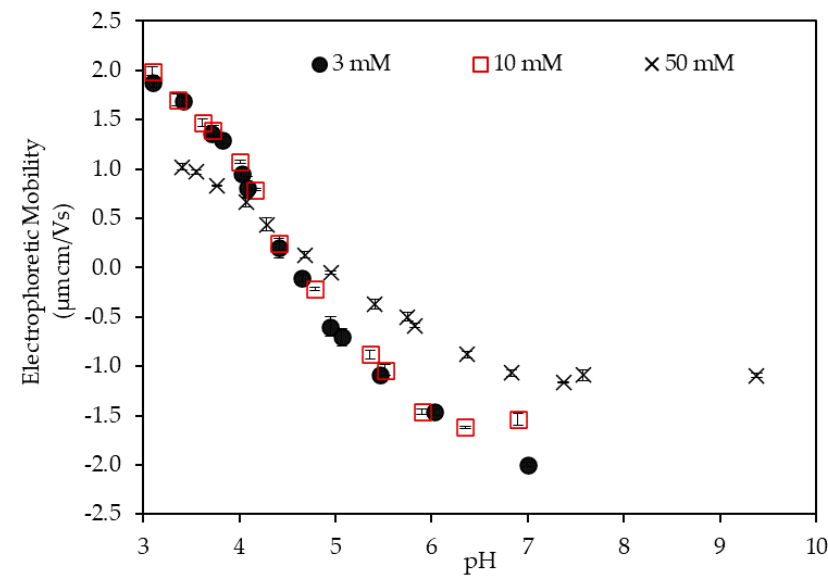
Figure 2. Electrophoretic mobility of the LSZ–LHA complex with mass ratio 2.5 at di ff erent KCl concentrations (3 mM, 10 mM, and 50 mM) against